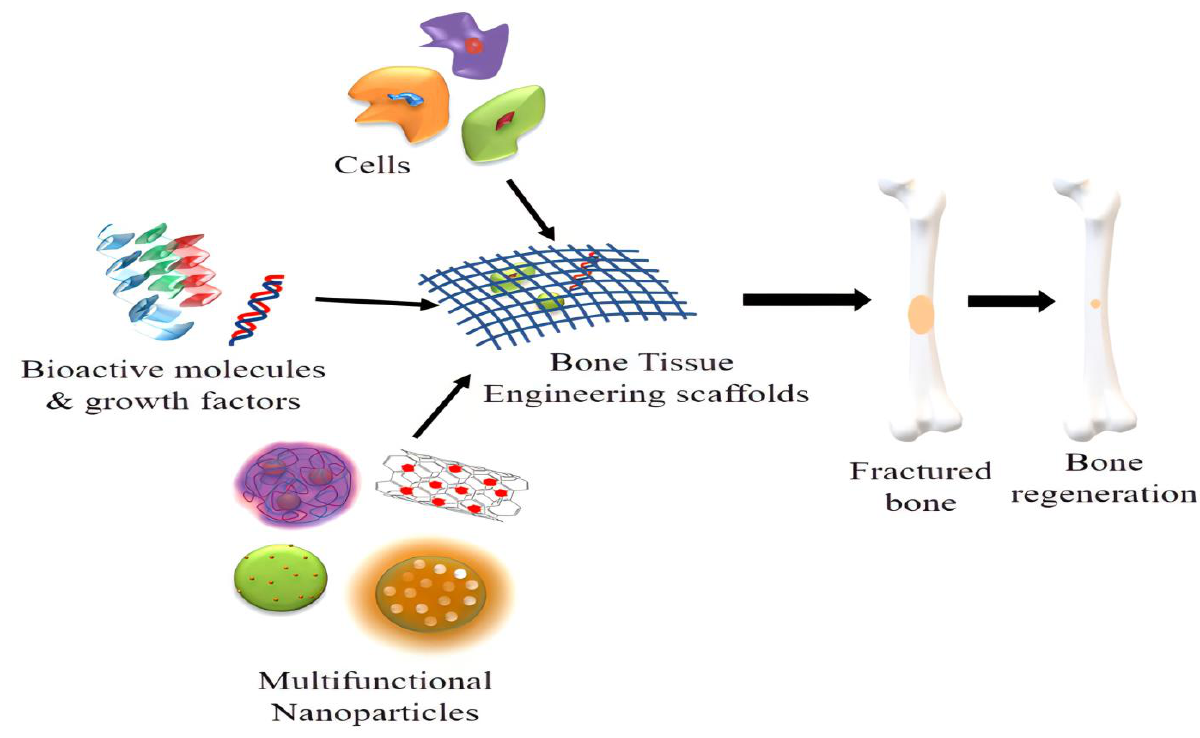
Figure 8. Nanofibrous composite scaffolds for bone tissue regeneration.